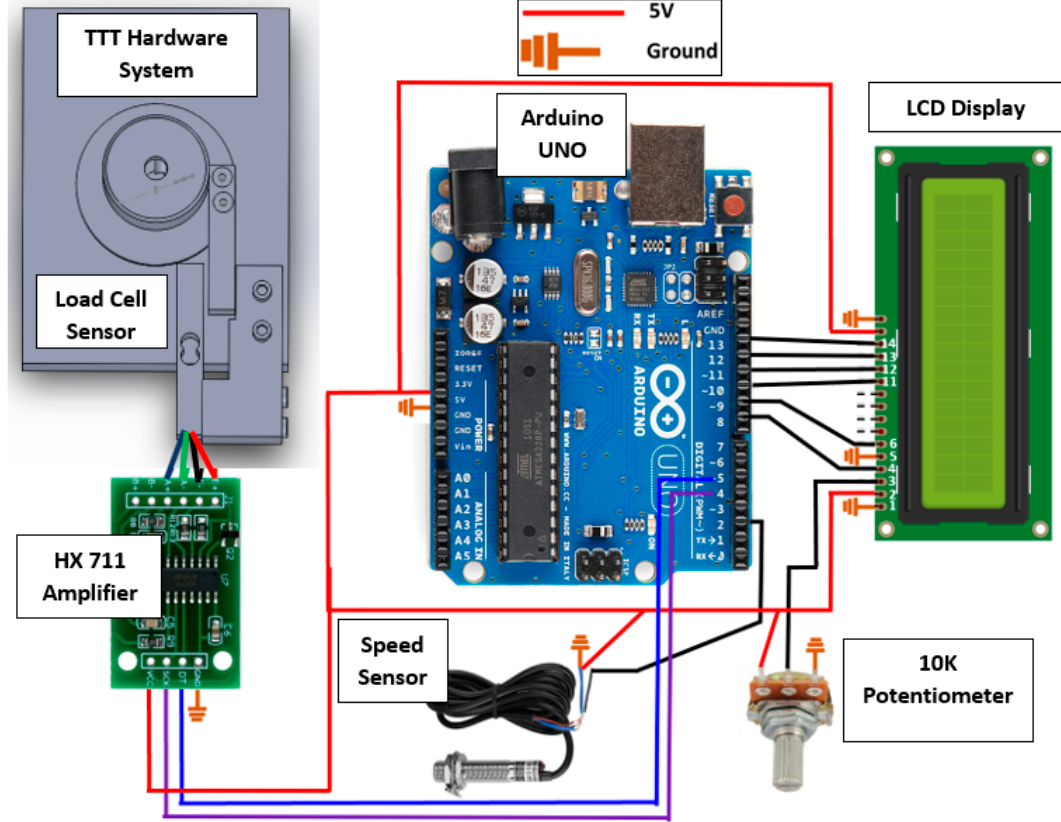
Figure 5. Instrumentation system diagram.